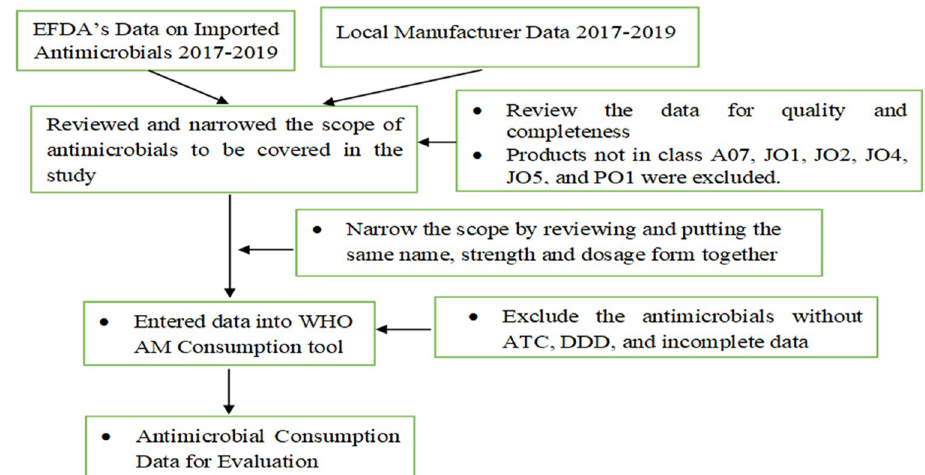
Fig 1. Data collection and cleaning process for antimicrobial consumption analysis.